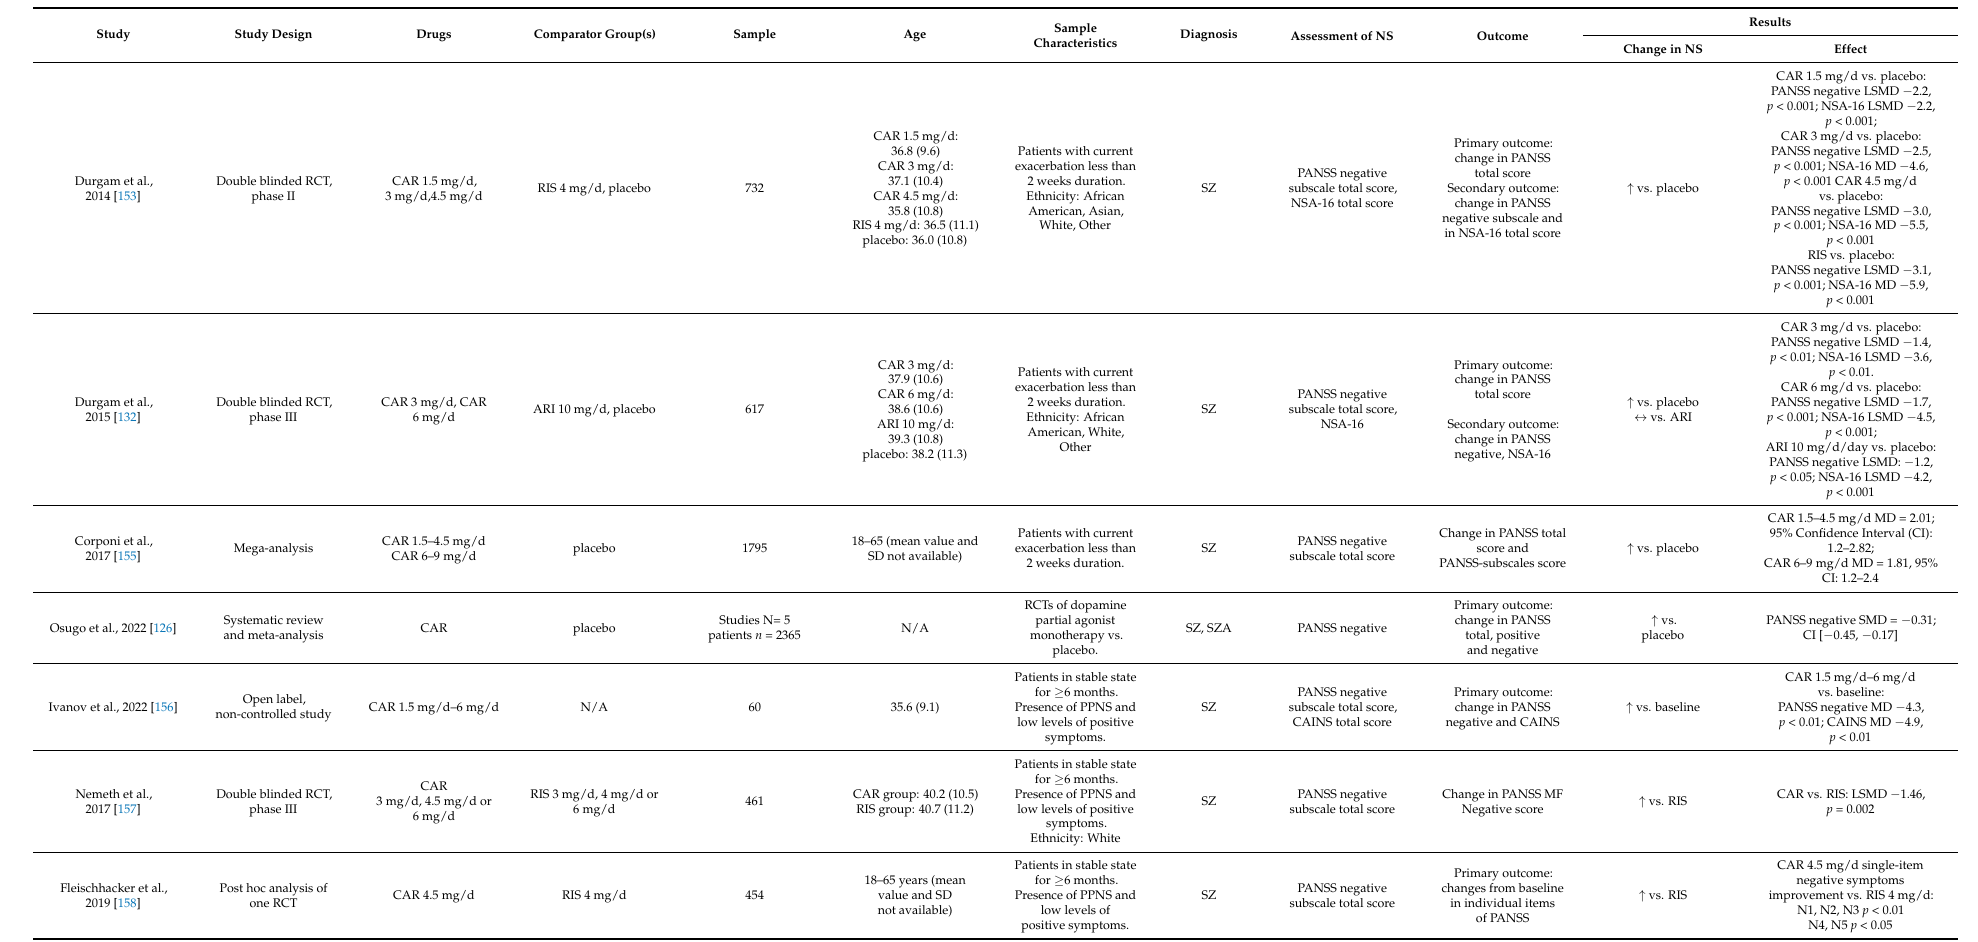
↑ better results; ↔ similar results; CAINS: Clinical Assessment Interview for Negative Symptoms; CAR: cariprazine; CI: confidence interval; LSMD: least square mean difference; MD: mean difference; N: number of studies; n: number of patients; N/A: not applicable; NS: negative symptoms; NSA-16: 16-item Negative Symptom Assessment; PANSS: Positive and Negative Symptoms Scale; PANSS MF: Positive and Negative Symptoms Scale Marder Factor; PPNS: persistent predominant negative symptoms; RCT: randomized control trial; RIS: risperidone; SMD: standardized mean difference; SZ: schizophrenia; SZA: schizoaffective disorder; vs.: